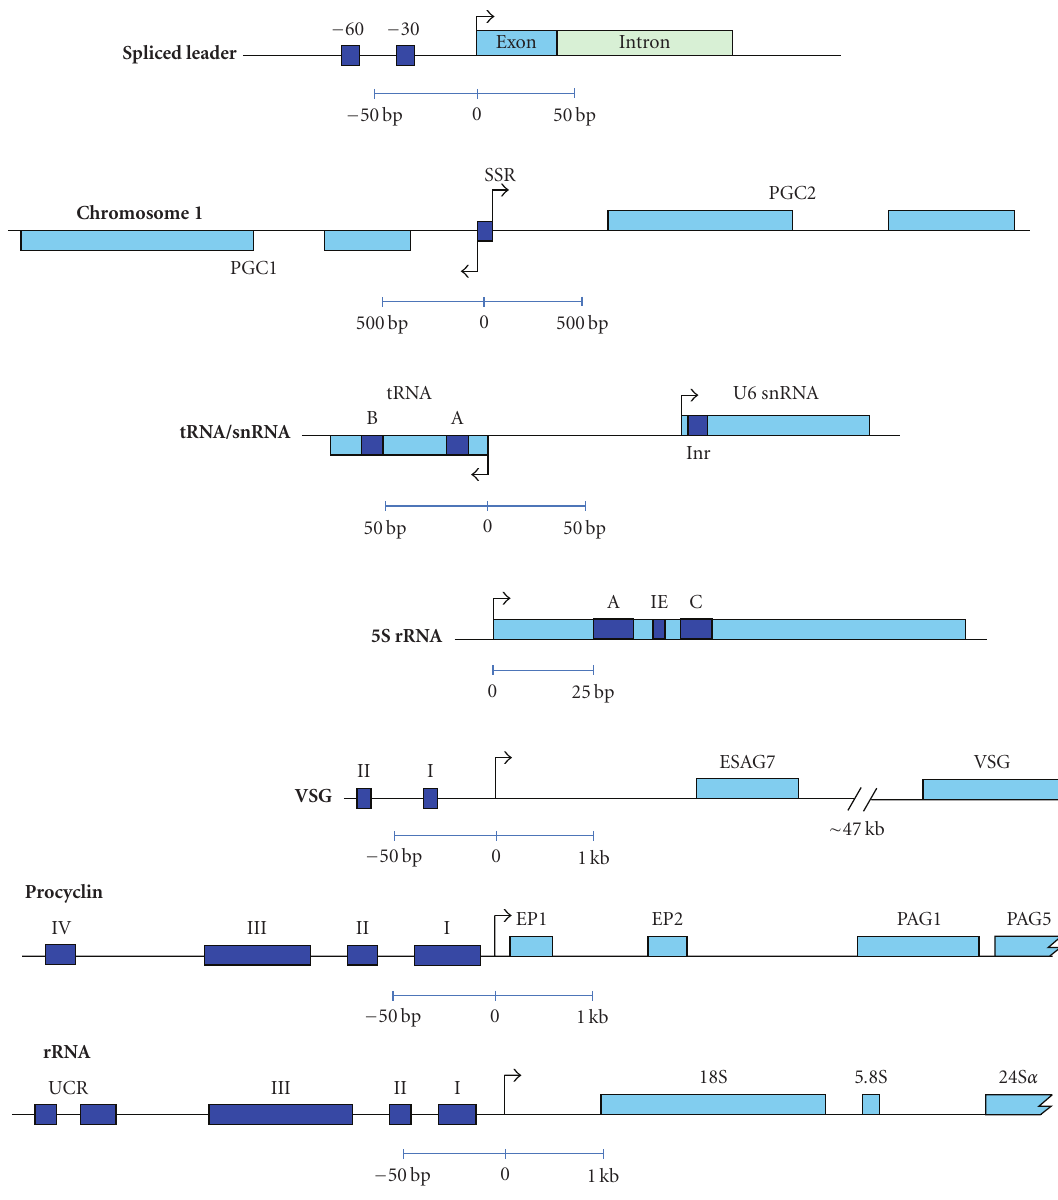
Figure 2: Schematic representation of promoter regions in trypanosomatids. Transcription start sites are indicated by arrows. DNA sequence elements required for transcription initiation are denoted by dark blue boxes. Coding regions are shown as light blue boxes. The spliced leader RNA and chromosome 1 (transcribed by Pol II) correspond to L. tarentolae and L. major , respectively. The tRNA/U6snRNA locus and the 5S rRNA (transcribed by Pol III) correspond to T. brucei . The VSG, procyclin and rRNA transcription units (transcribed by Pol I) also correspond to T. brucei . The spliced leader RNA promoter contains the − 30 and − 60 elements [51]. In the divergent strand-switch region (SSR) from chromosome 1 several TSSs were mapped, in a ∼ 70 bp region, for both PGCs [29]. The tRNA gene possesses boxes A and B